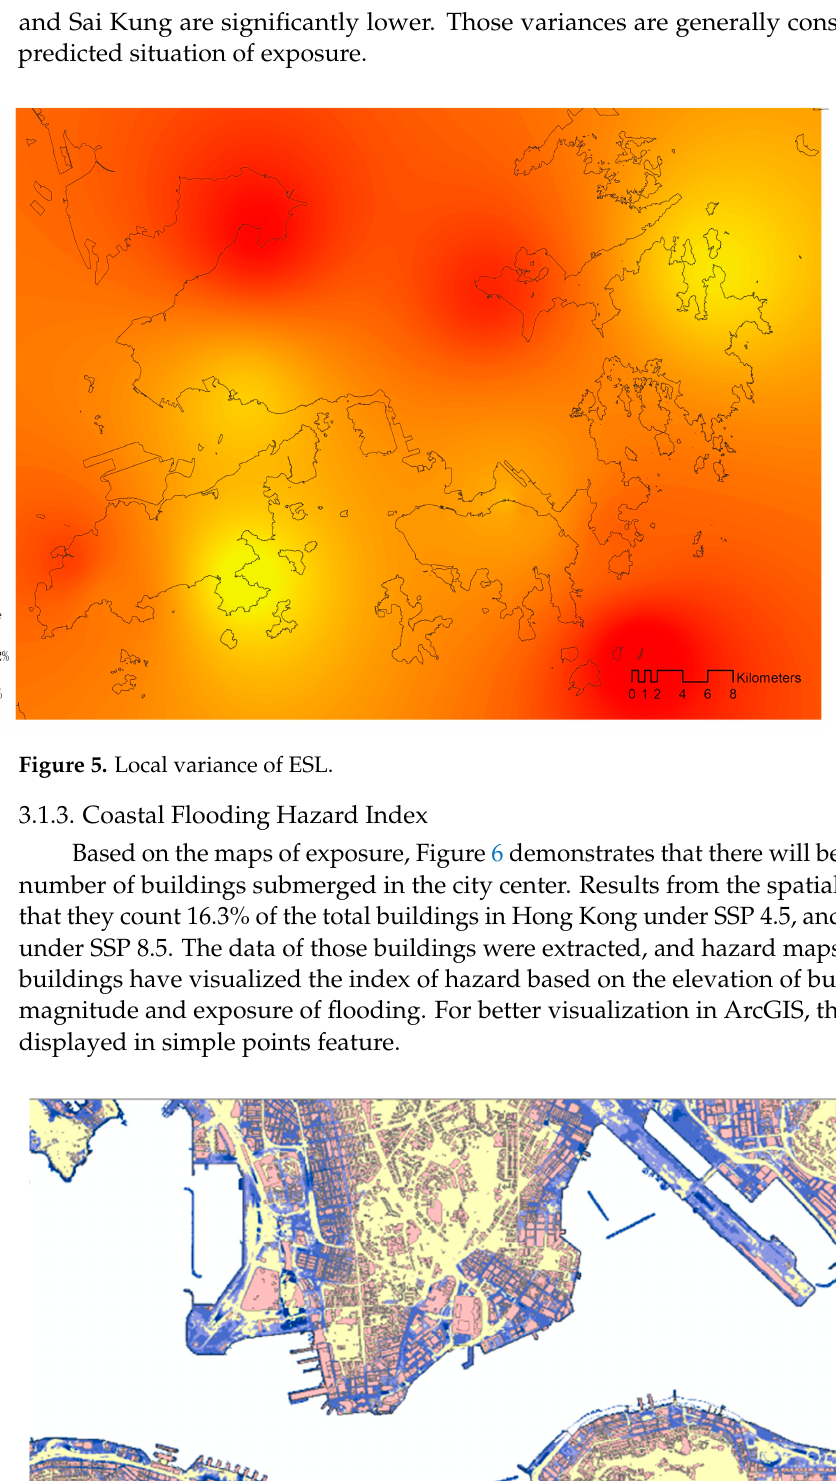
Figure 7. Map of hazard index for buildings (SSP 4.5).